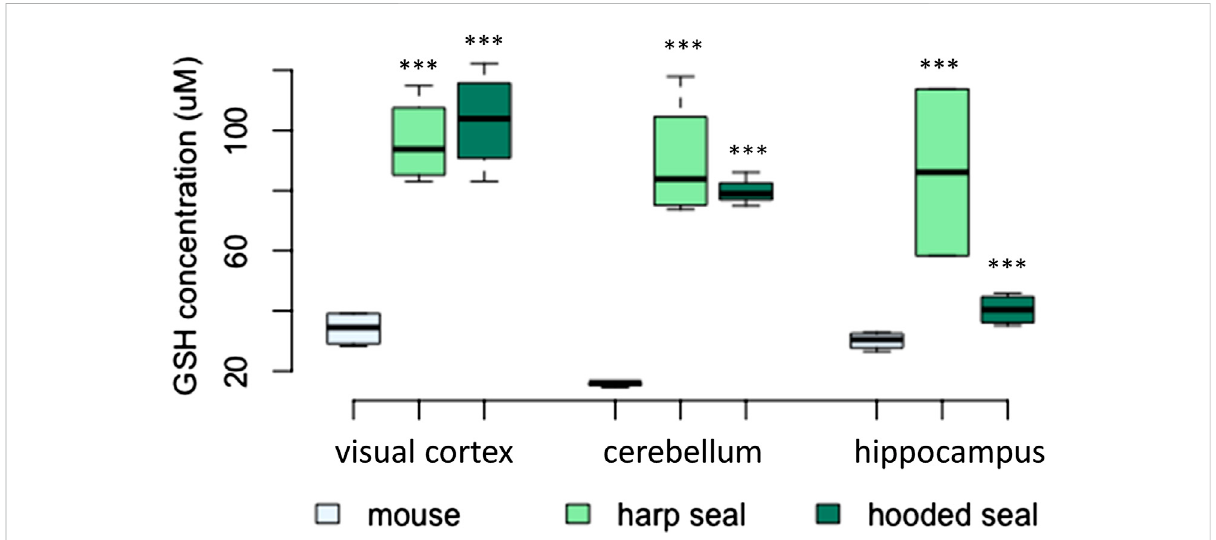
The concentration of reduced glutathione (GSH, μ M) in mice, harp seals and hooded seals. Signi fi cance levels refer to differences compared to mice in the respective brain region and are represented by asterisks ( p ≤ 0.05 (*), p ≤ 0.01 (**), p ≤ 0.01